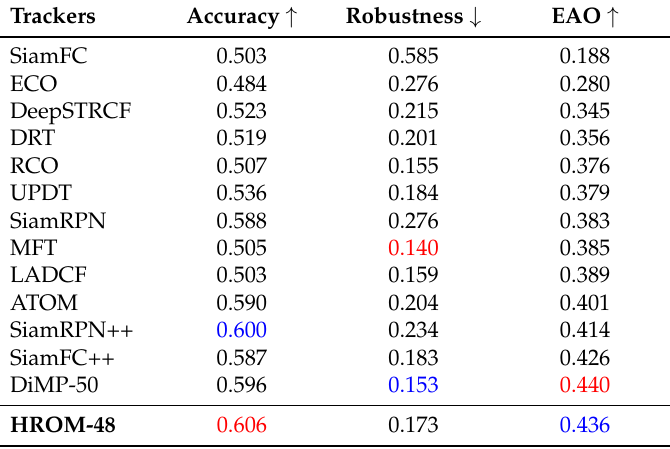
Table 4. Comparison with 14 tracking methods on VOT-2018 benchmark. The red font and blue font represent the top-ranking and second-ranking performance, respectively.